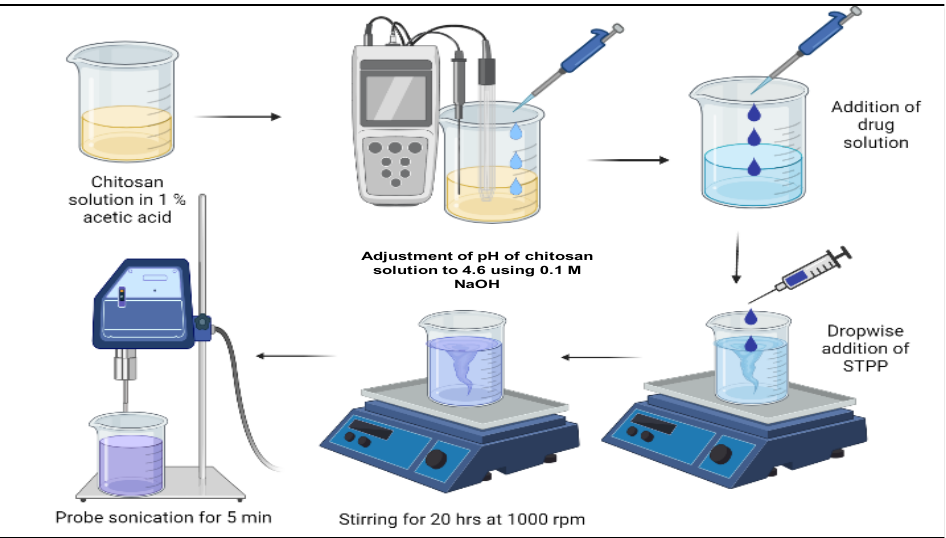
Figure 3. Schematic representation of ionic gelation method for the preparation of chitosan nanoparticles. Initially, chitosan solution was prepared and adjusted pH, followed by the addition of drug to it. Crosslinker was added dropwise and allowed to stir for overnight. Final formulation subjected to sonication for specific time.